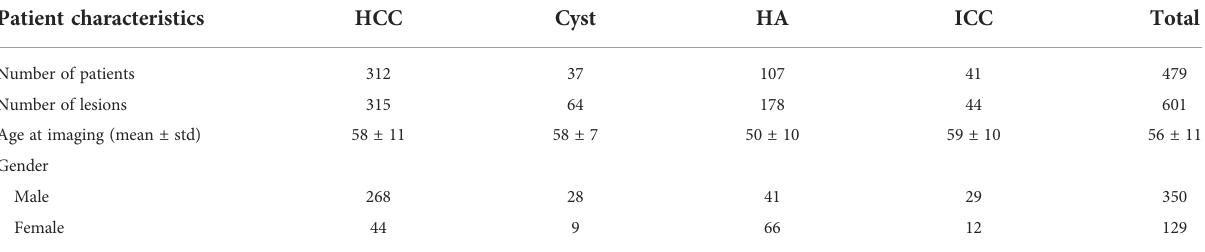
TABLE 1 Patient characteristics and demographics.